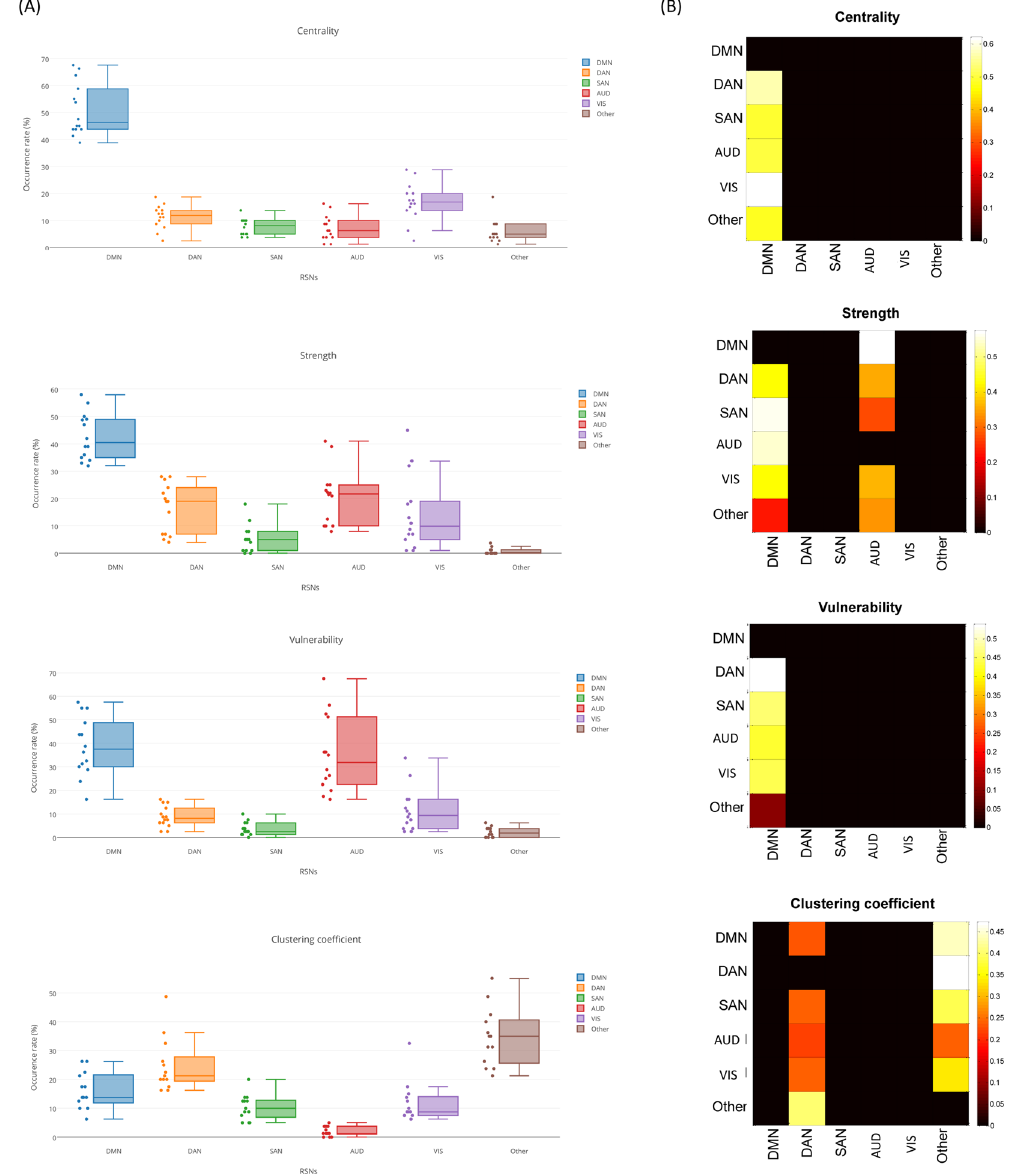
Figure 5. Dynamic analysis: networks transition. ( A ) The occurrence rates of the DMN, SAN, DAN, VIS, AUD and Other RSNs across time windows for all participants. ( B ) The temporal transitions between all networks across time windows for all participants. Only significant columns are shown ( p < 0.01, Bonferroni